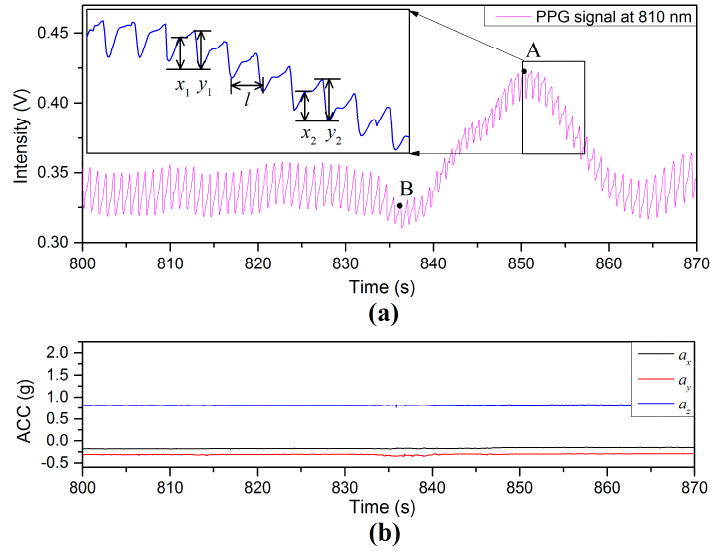
Figure 13. ( a ) PPG signal and ( b ) ACC signals with a deep yawn event.